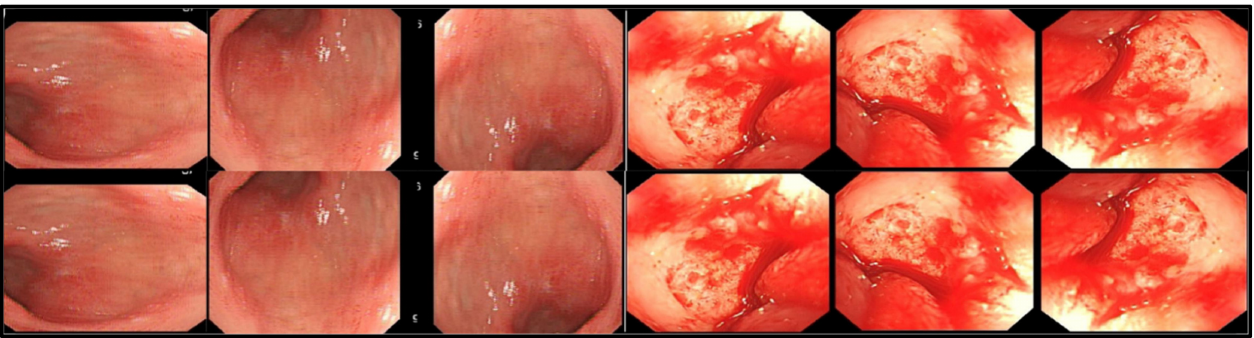
Figure 2. Sample Images after data